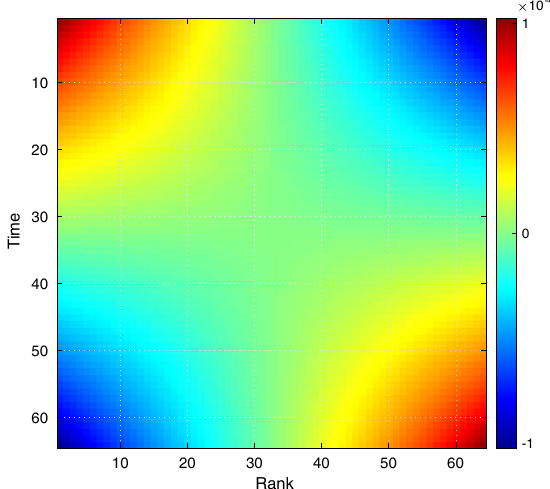
FIG. 18. h Q i as a filtered product of P . Here, the contracting row vector m T ¼ 1 T M is reshaped as a matrix to clarify its role in extracting a trend from P